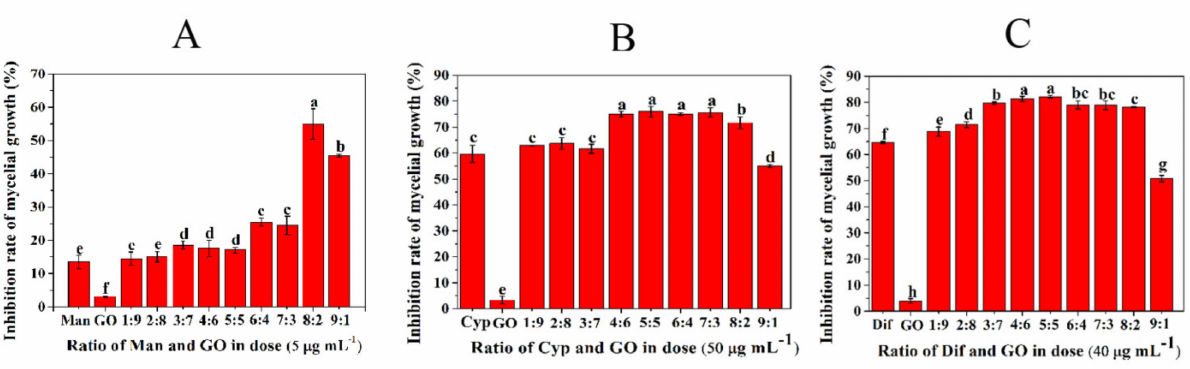
Figure 1. Inhibitory activities of single fungicides or in combination with GO at different mass ratios against mycelial growth of F. graminearum . Inhibitory activities of Man and GO ( A ), Cyp and GO ( B ) and Dif and GO ( C ) at different mass ratios against mycelial growth of F. graminearum . Data are mean ± stand error (SE). Error bars represent the SE (N = 4). Different lowercase letters indicate significant differences between treatments ( p <